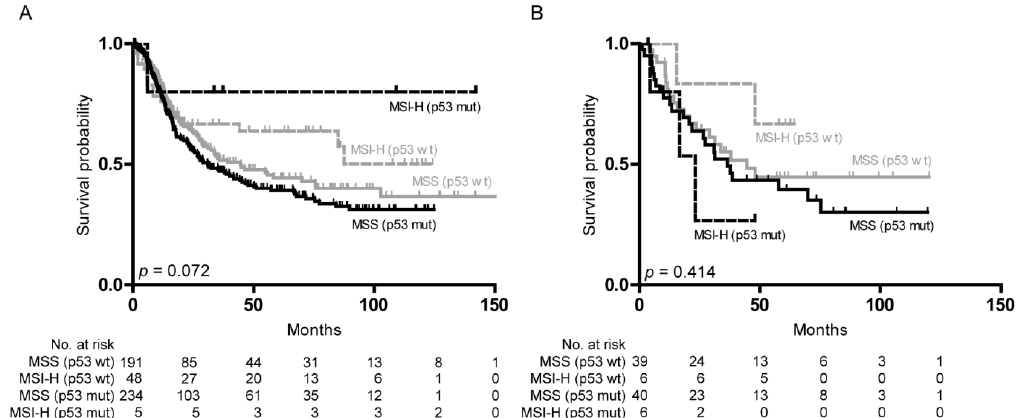
Figure 4. Survival of the patients with MSI-H and MSS/EBV − tumors and association with p53 expression. Kaplan–Meier curves of the patients with MSI-H and MSS/EBV − tumors and association with p53 expression in resection specimens ( A ) and biopsies before CTx ( B ). EBV(+), Epstein–Barr virus-positive; EBV( − ), Epstein–Barr virus-negative; MSI-L, low microsatellite instability; MSS, microsatellite stable; MSI-H, high microsatellite instability; p53 wt, p53 wild-type expression; p53 mut, aberrant p53 expression; No., number; p -value of log-rank test (overall).